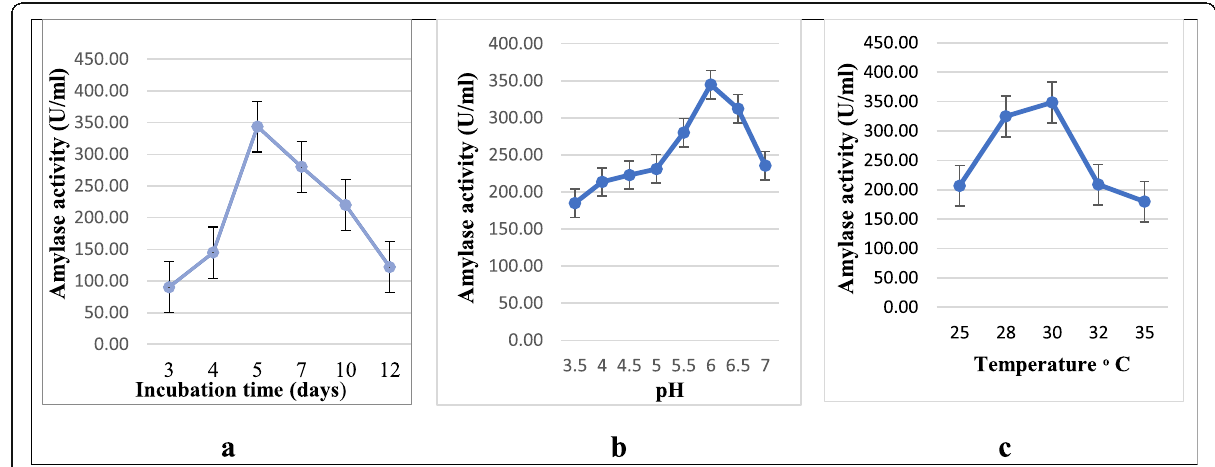
Fig. 4 Effect of different incubation time ( a ), different pH ( b ), and different temperature ( c ) on α -amylase produced by Aspergillus terrus